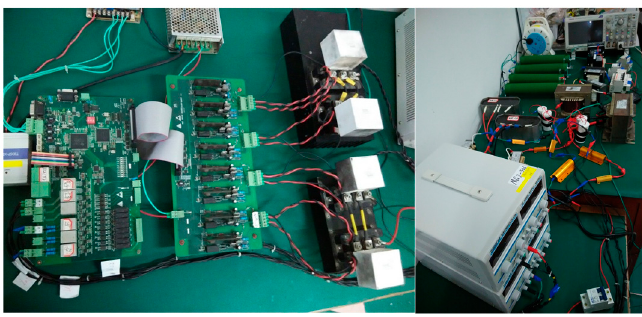
Figure 13. Experimental prototype setup of an AC MG. Table 3. Parameters for experiments.